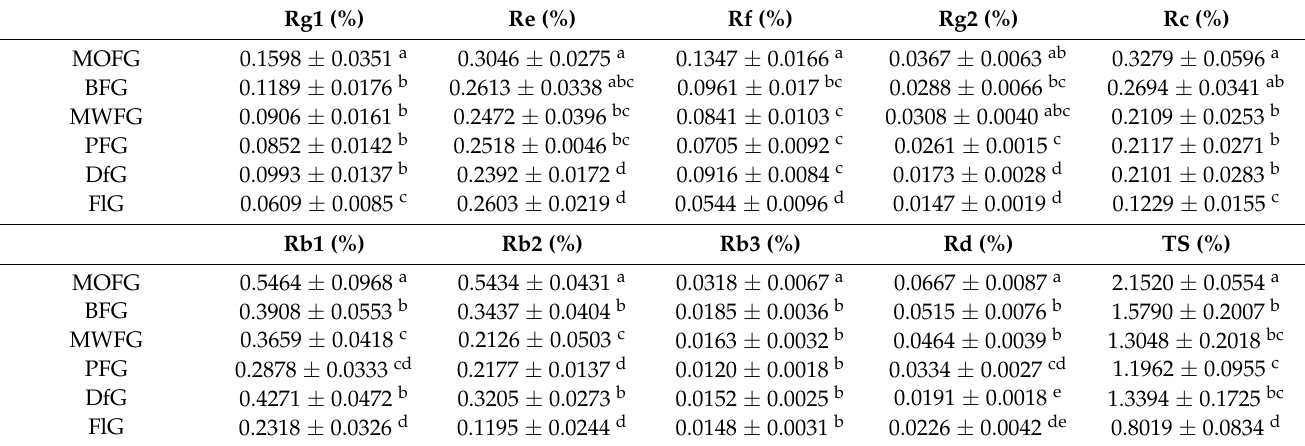
Table 1. The ginseng saponin content in different planting